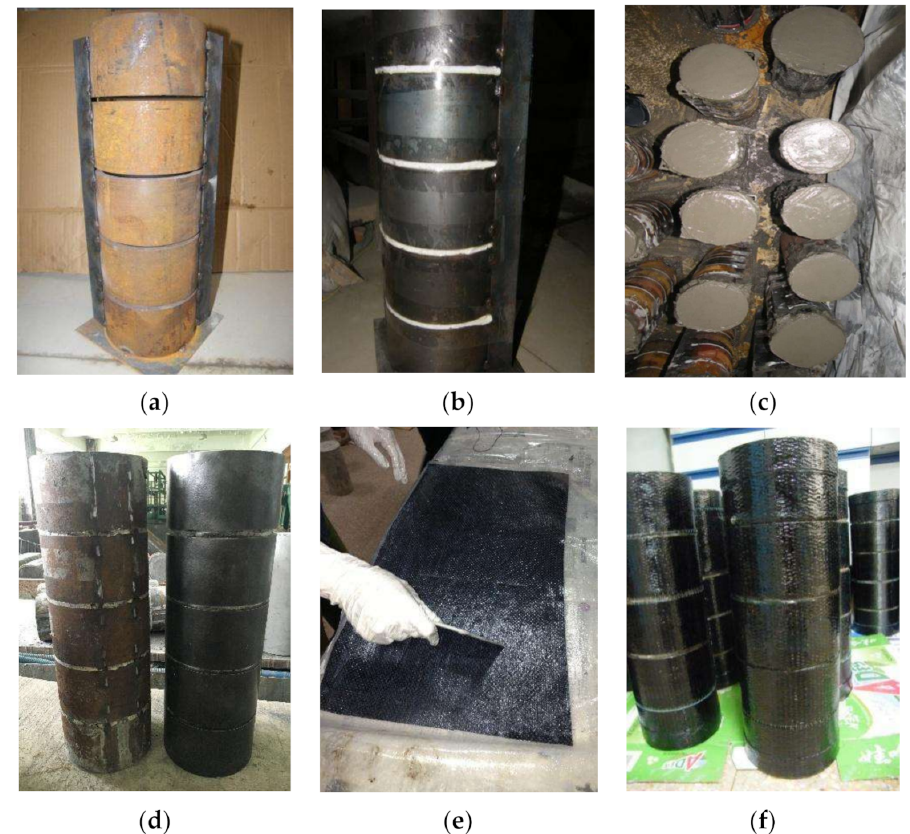
Figure 3. Process of forming the CFGCT columns. ( a ) Setting up the grooved steel tubes. ( b ) Filling in the circumferential gaps. ( c ) Pouring the concrete. ( d ) Surface treatment of steel tubes. ( e ) Impregnating the FRP sheets. ( f ) Wrapping the FRP